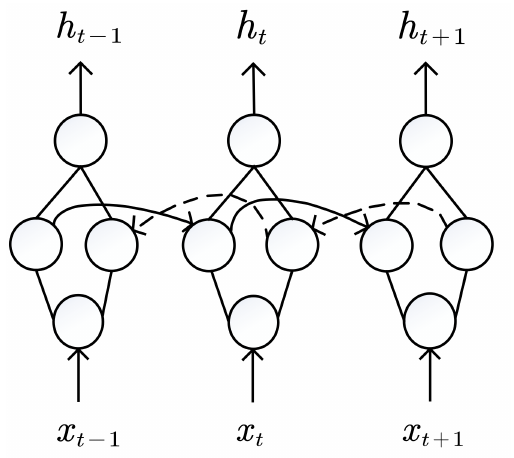
Figure 3. BiGRU structural